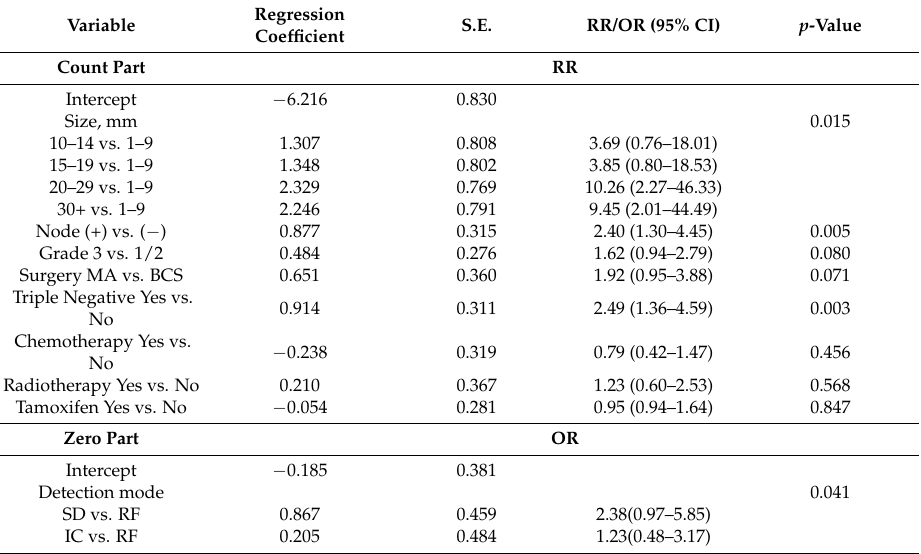
Table 3. The regression coefficient of Zero-inflated Poisson regression model and overdiagnosis